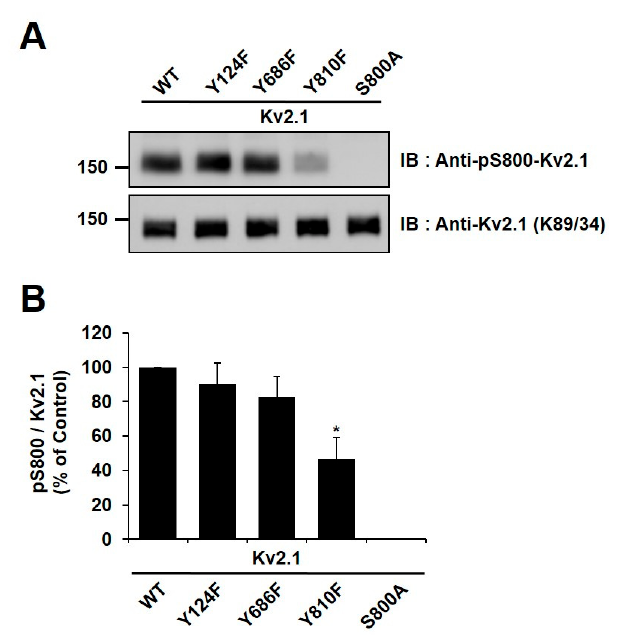
Figure 5. Phosphorylation sites Y810 and S800 of the K v 2.1 channel were mutually co-regulated during oxidative stress. ( A ) HEK293 cells were transfected with K v 2.1-WT or the K v 2.1